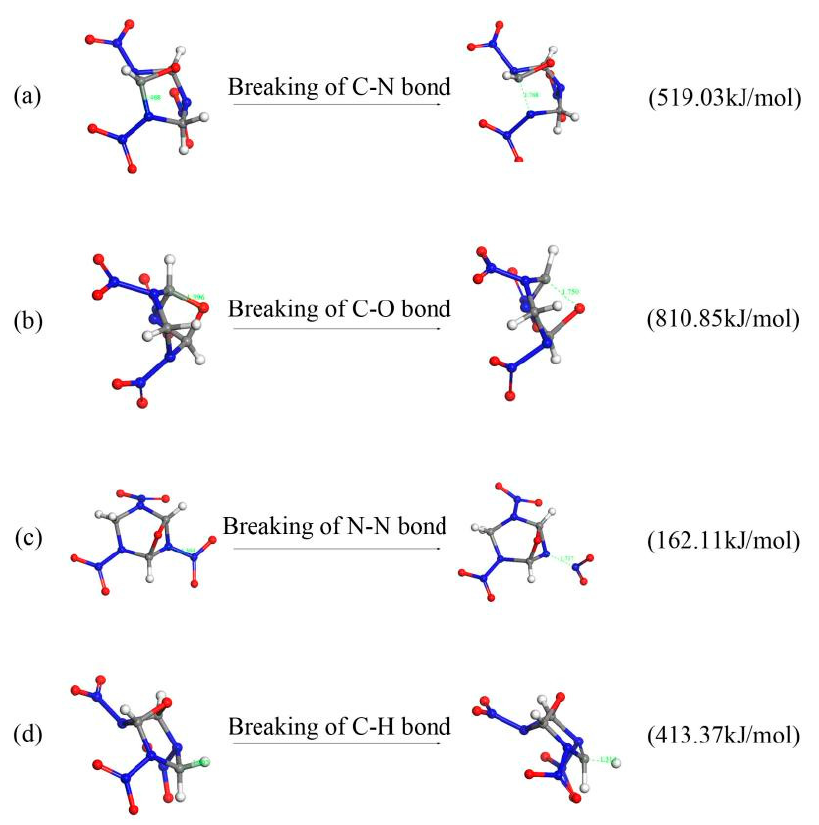
Figure 7. Four different initiation reactions in the thermal decomposition of the R3 crystal.